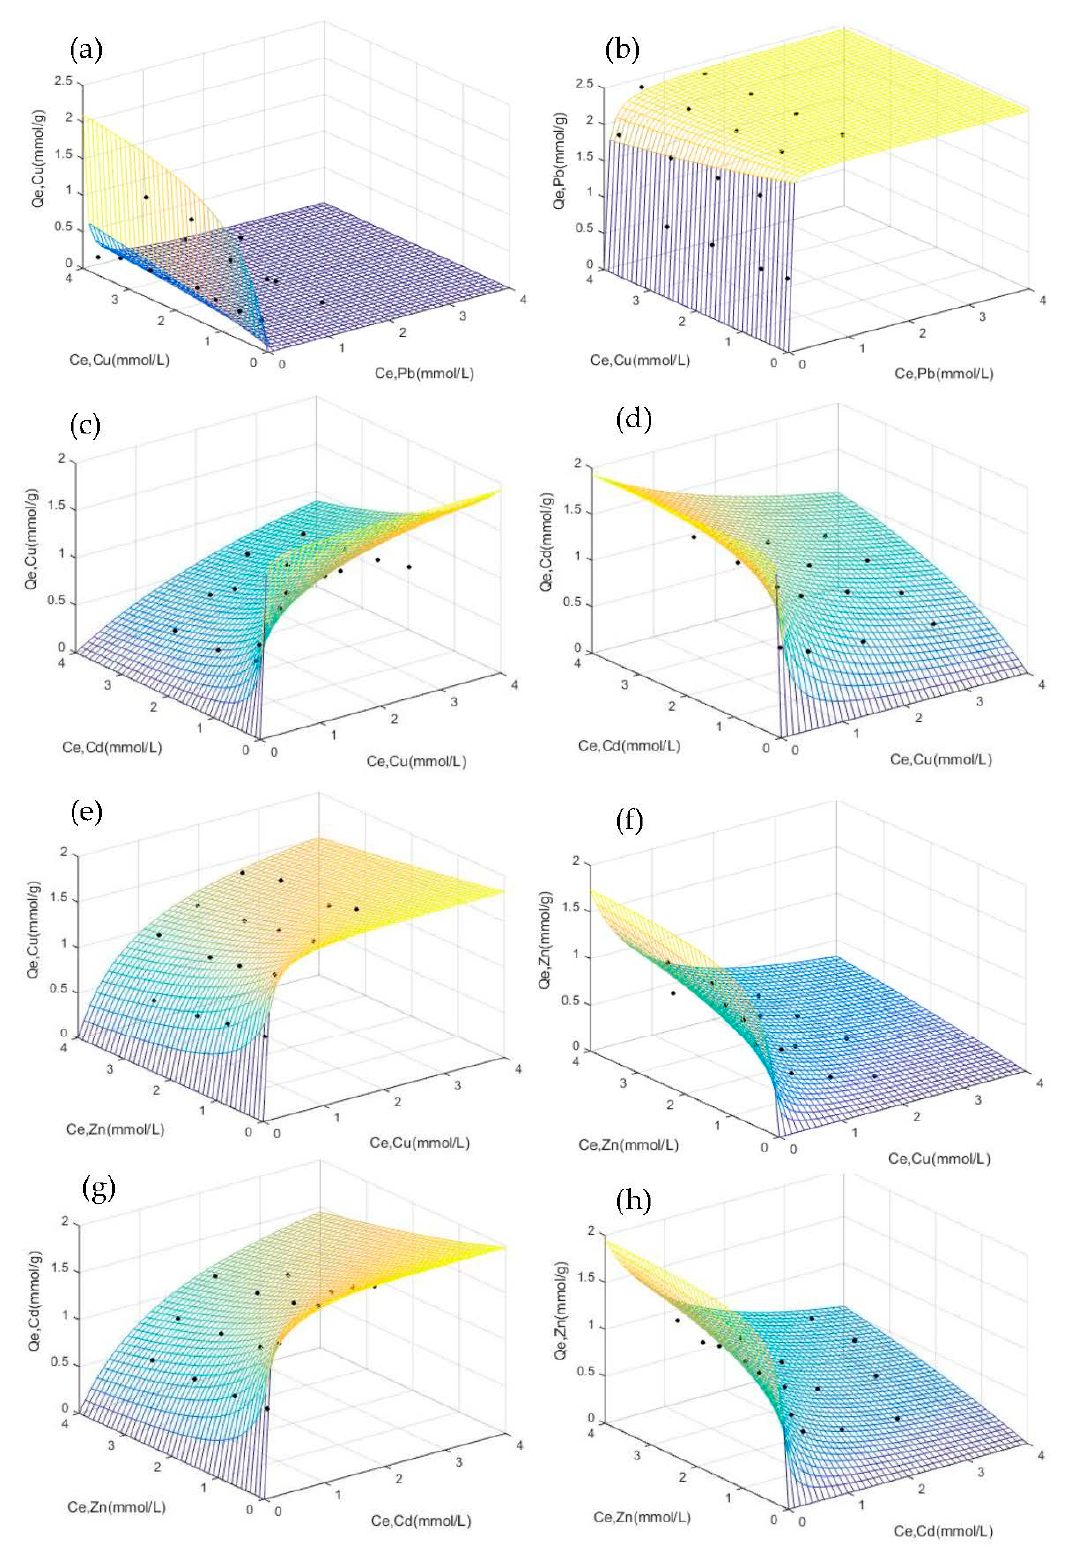
Figure 3. Adsorption capacity of heavy metals by NaX zeolite and three-dimensional isotherm surfaces simulated with the extended Langmuir isotherm model: Cu 2+ -Pb 2+ binary system ( a , b ), Cu 2+ -Cd 2+ binary system ( c , d ), Cu 2+ -Zn 2+ binary system ( e , f ) and Cd 2+ -Zn 2+ binary system ( g , h ).